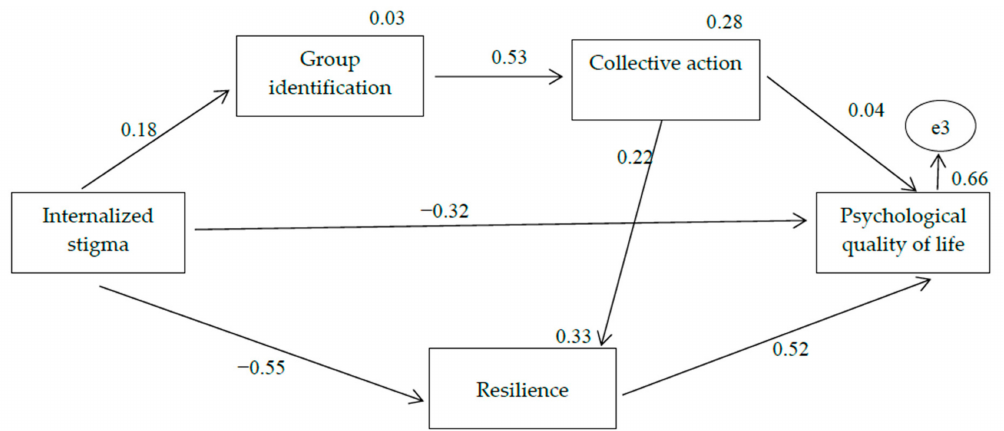
Figure 2. Standardized regression coe ffi cients of the proposed model. Note: The percentage of explained variance is indicated in italics above the variable. All direct e ff ects were significant ( p < 0.01), except β = 0.04 ( p = 0.31).